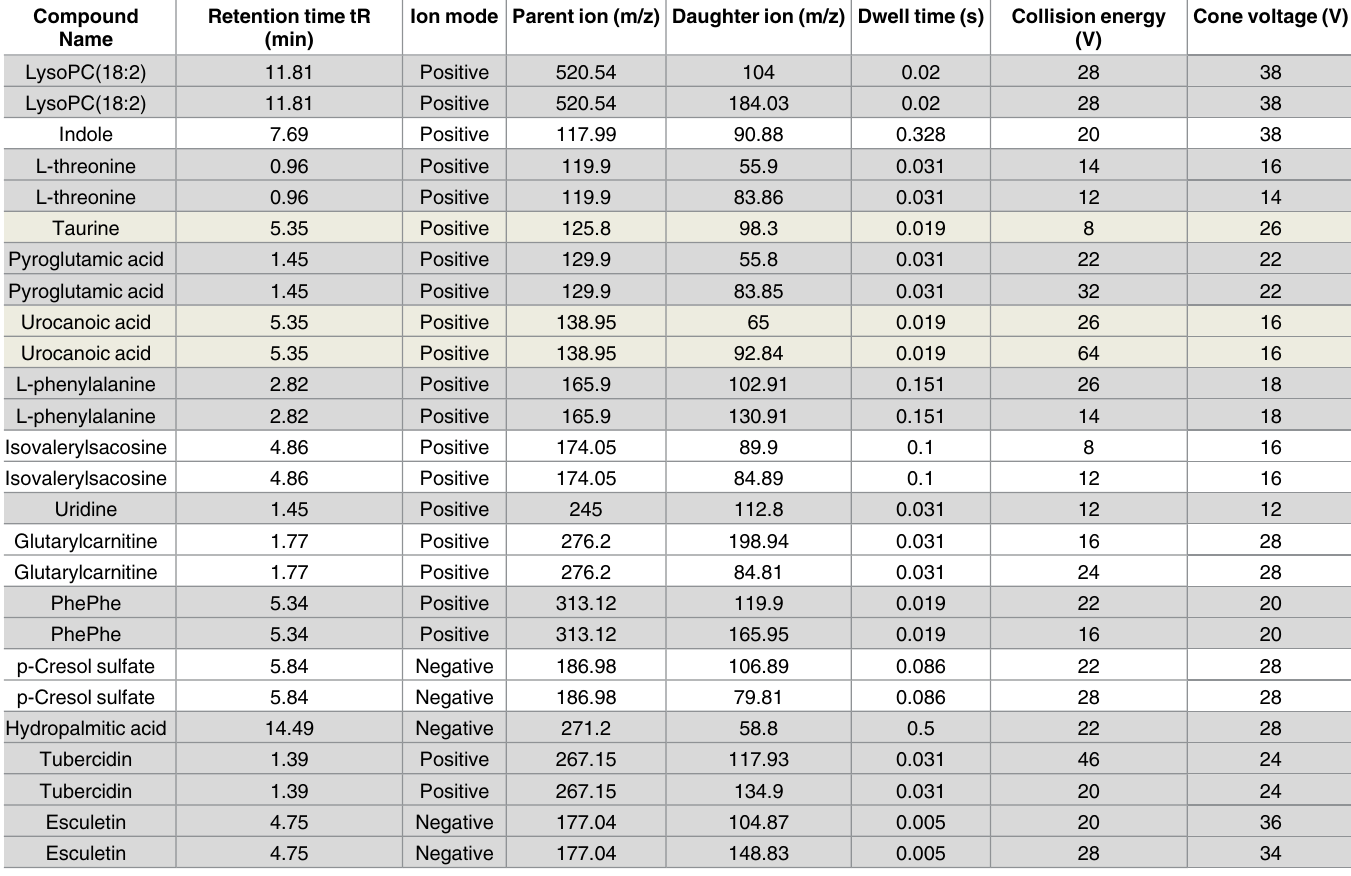
Table 1. Retention time and LC/MRM-MS parameters for 13 standard compounds and 2 internal